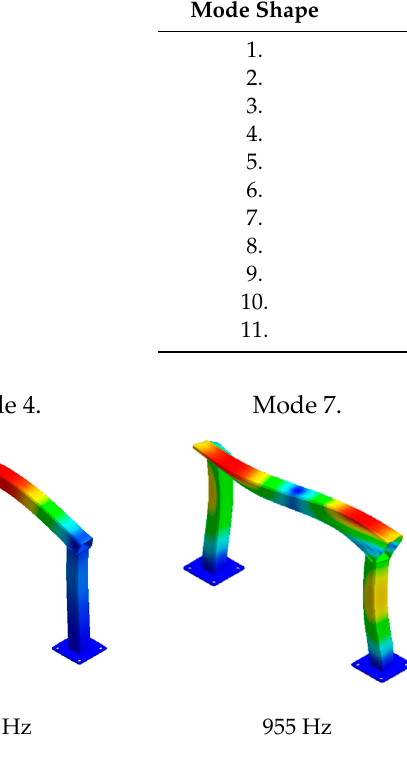
Figure 11. Steel frame mode shapes characterized by transverse beam vibrations. Table 6. Natural frequency values of the steel frame.